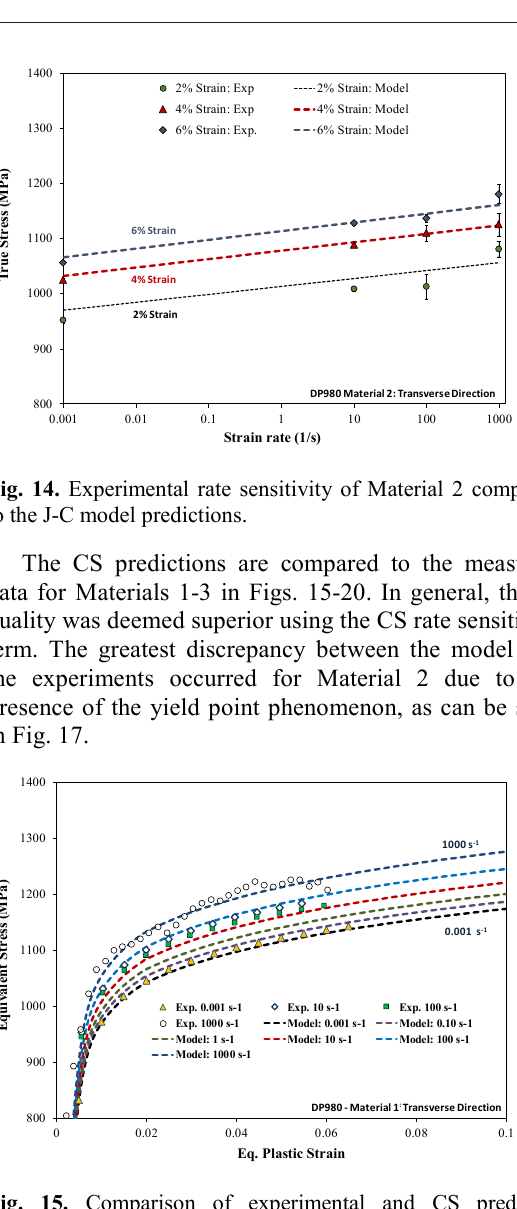
Fig. 15. Comparison of experimental and CS predicted equivalent stress and equivalent plastic strain for Material 1.